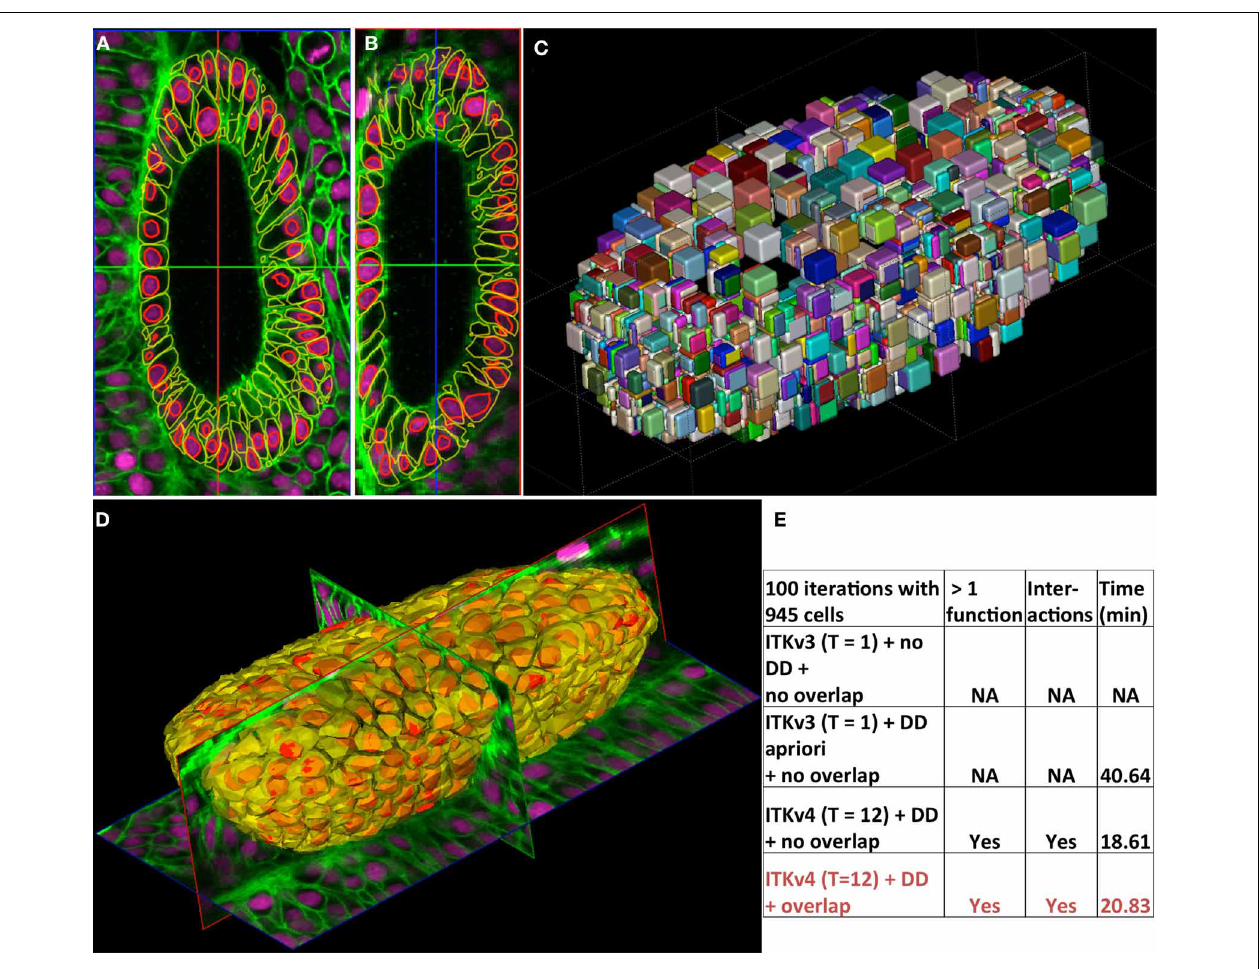
FIGURE 6 | Demonstration of cell segmentation in large 3D nuclear+membrane confocal microscopy data of a developing zebrafish ear at 24h post-fertilization. The images depict cell membranes in green (membrane-targetted mCitrine) and nuclei in magenta (H2B-tdTomato). The images are of dimensions 1024 × 1024 × 72 with a pixel sampling of 0.2 μ m × 0.2 μ m × 1.0 μ m. A total of 485 whole cells and 461 nuclei were automatically identified by seeding level-sets at centers first identified by a Hough transform. (A) XY and (B) XZ sections showing membrane and nuclei